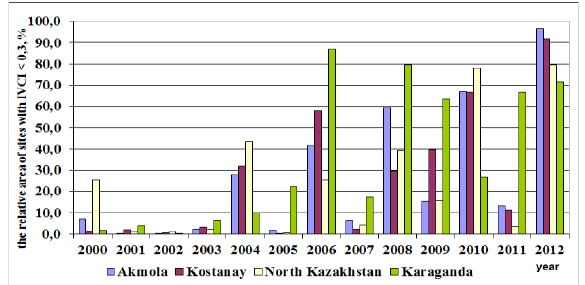
Figure 7. The areas of plots with values of IVCI <30% for some Kazakhstan’s oblasts